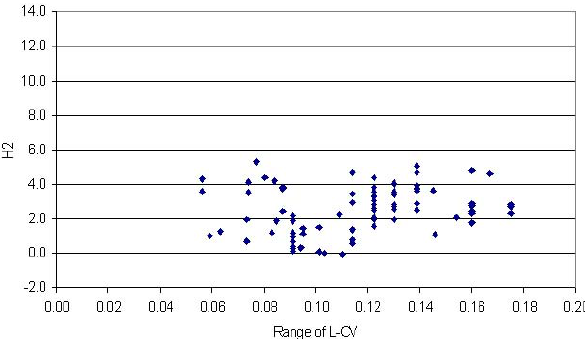
Fig. 5. H2 plotted versus range of L-CV. Each point represents a pooling group.